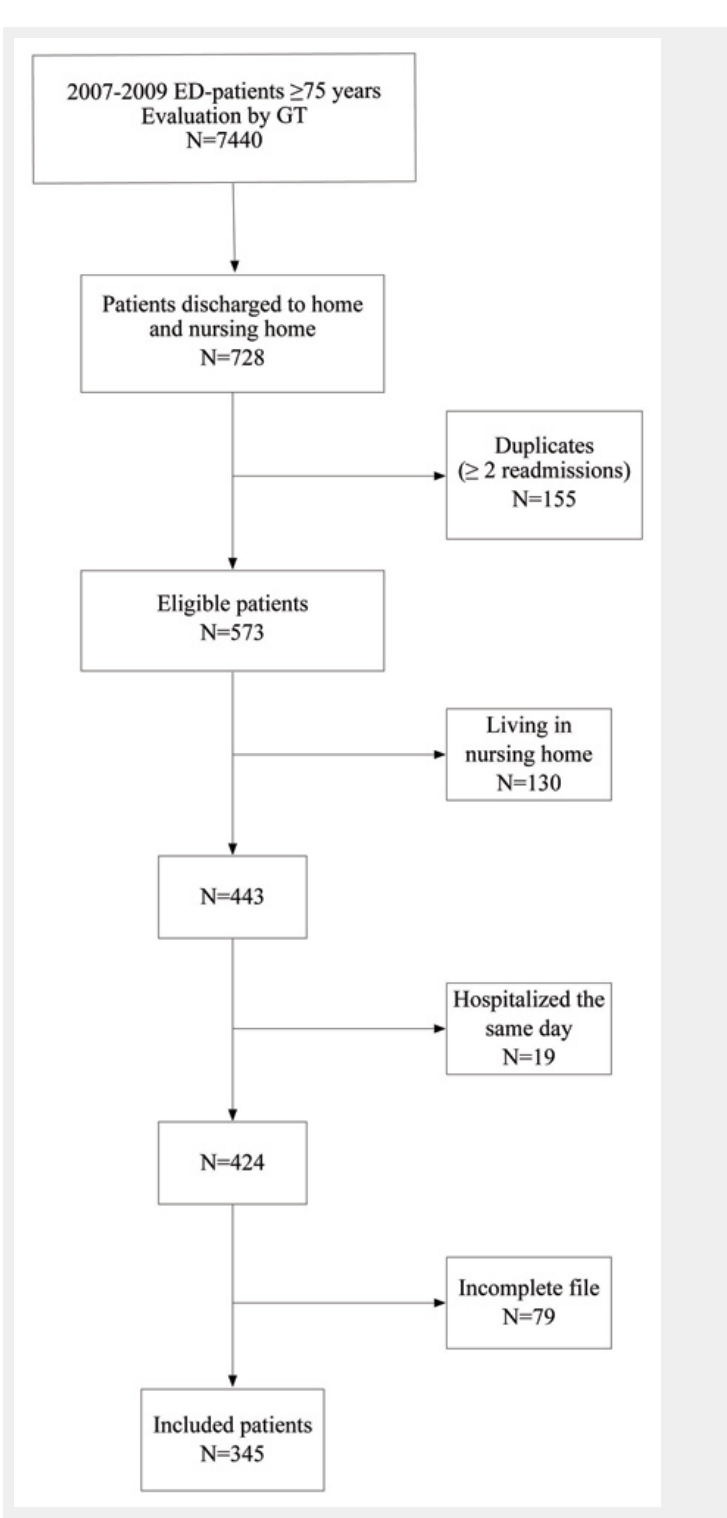
Figure 1 Flow diagram of the studied population. ED: Emergency Department. GT: Geriatric